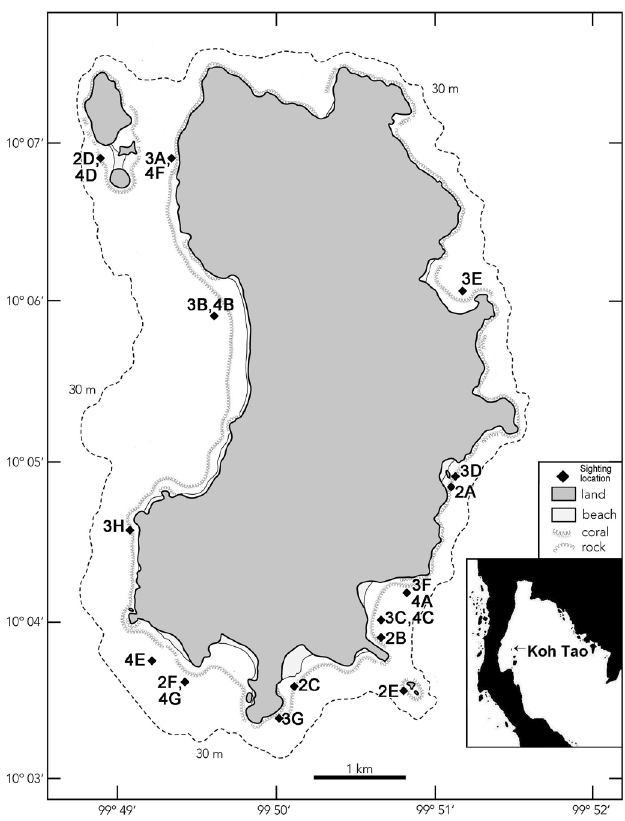
Map of the study area showing the locations of the sightings for the photographs shown in Figures 2-4. Codes on the map refer to the figure number and plate letter for each